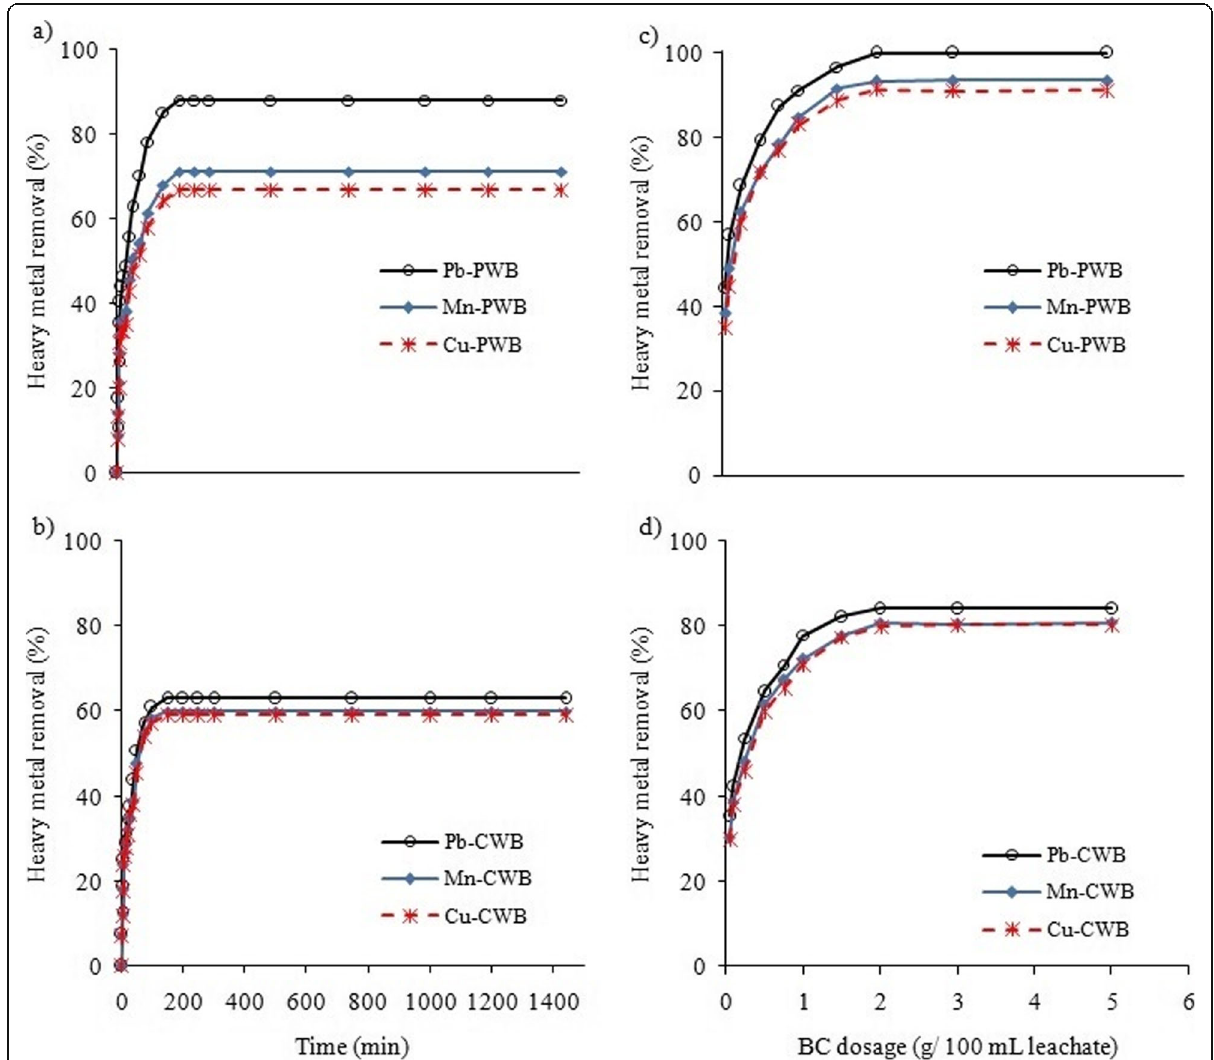
Fig. 1 Effect of contact time and biochar dosage on removal of heavy metals from landfill